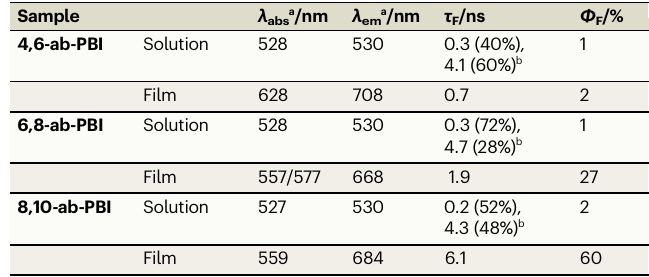
Table 2 | Optical and photophysical properties of the PBI derivatives in chloroform solution, and as annealed spin- coated PBI thin fi lms